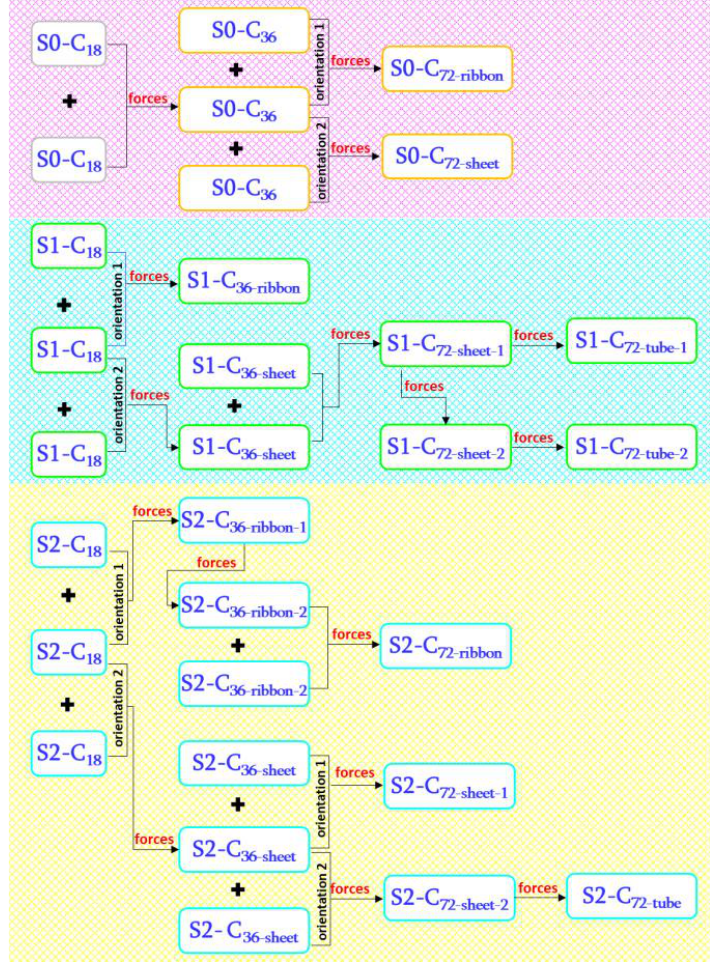
Figure 4. Scheme of the generation of the isomers of C 18 , C 36 and C 72.